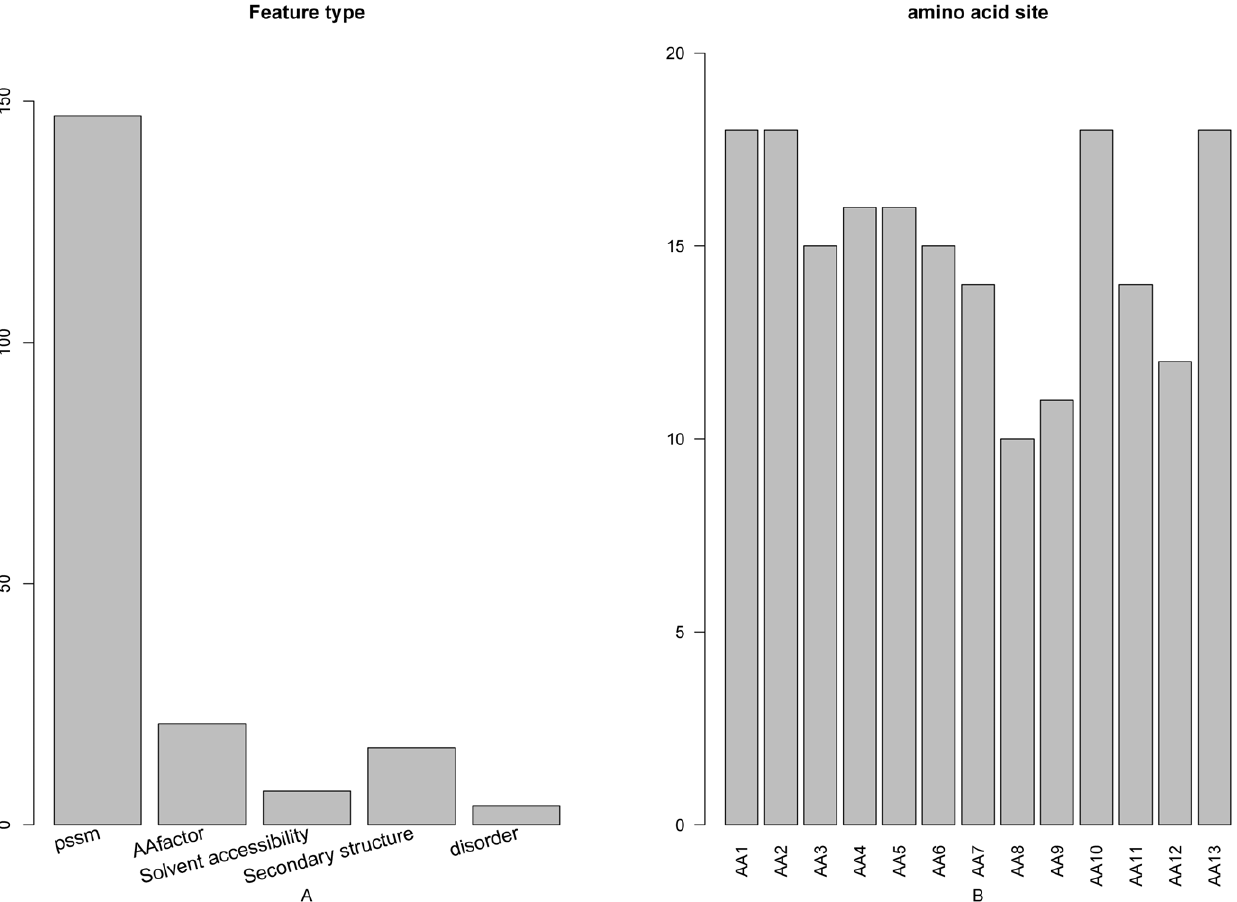
Figure 2. A 2-dimensional histogram to characterize the final optimal features set. The impact on the domain prediction from ( A ) the five different feature types, and ( B ) each of the 13 subsites. See the text for further explanation. doi:10.1371/journal.pone.0039308.g002 PLoS ONE |